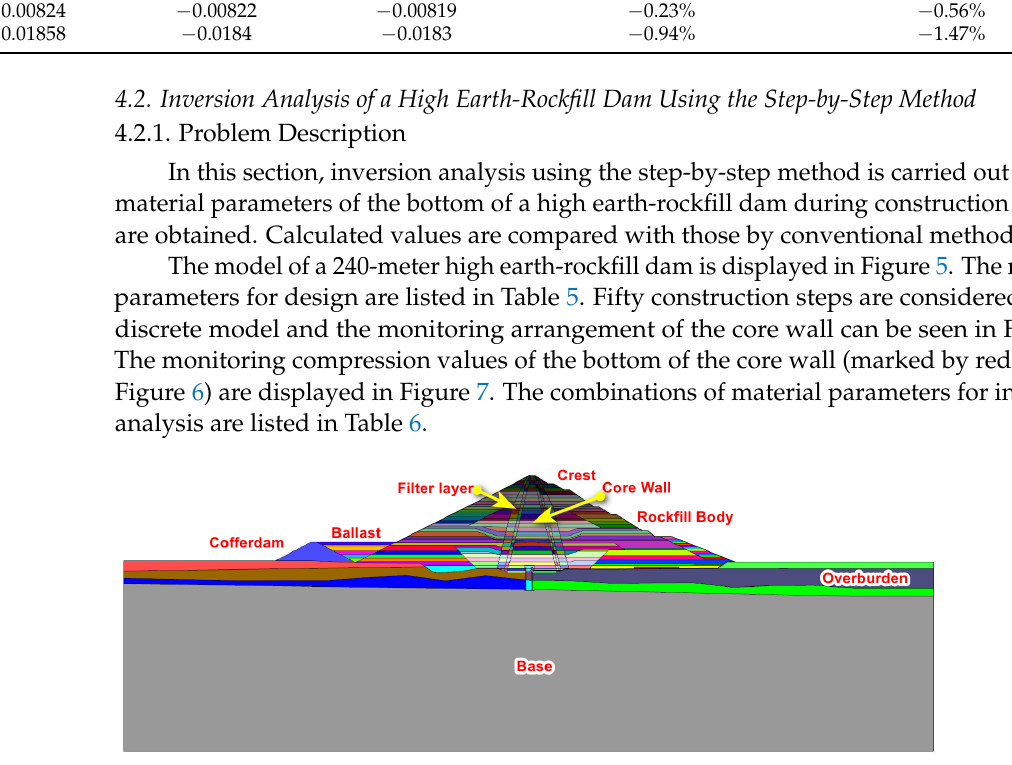
Figure 5. Construction layered model of a high rockfill dam. Table 5. Material parameters for design.